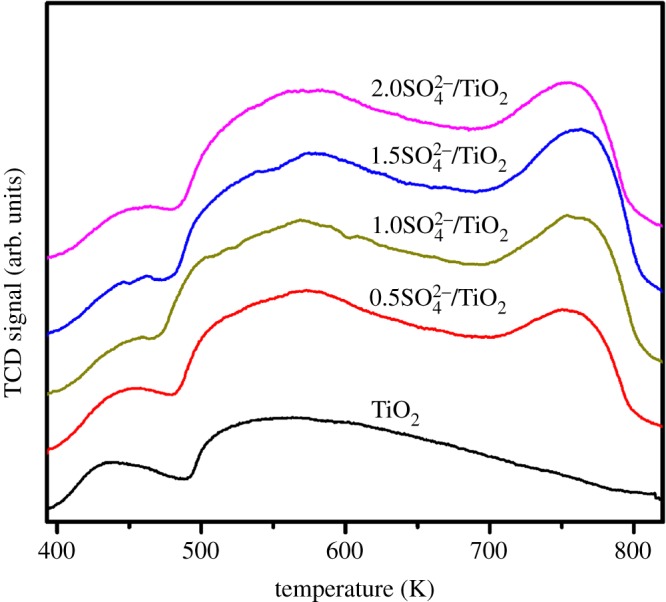
NH3-TPD spectra of the TiO2 and SO42−/TiO2 samples.